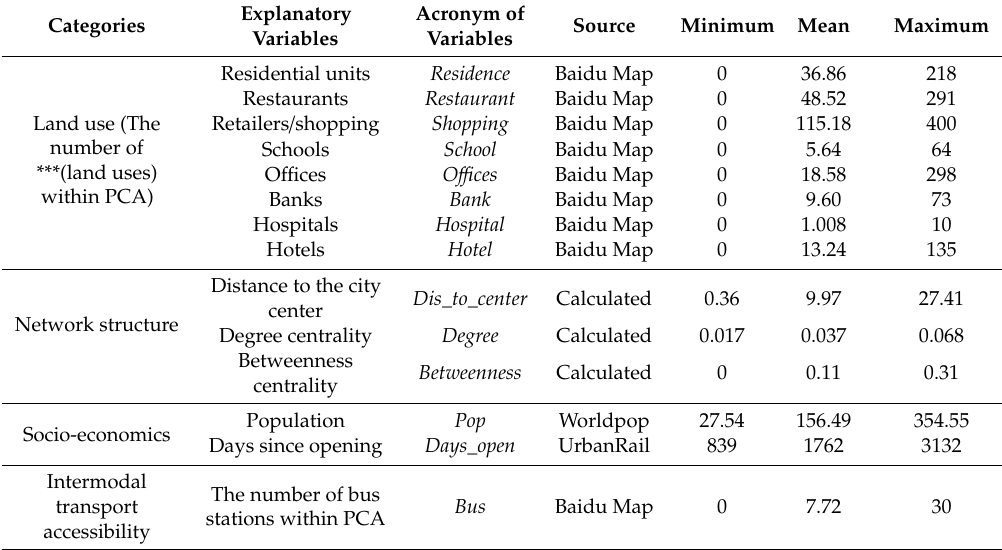
Table 2. Summary of explanatory